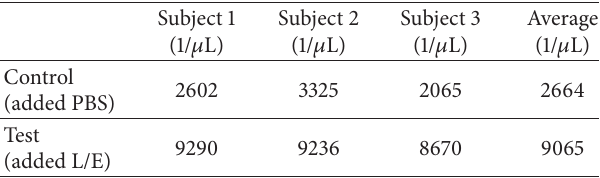
Table 1: Number of events within the chosen flow cytometer SSC- A/FSC-A region corresponding to platelets and EVs (Figure 1) in the isolate from blood treated with L/E.